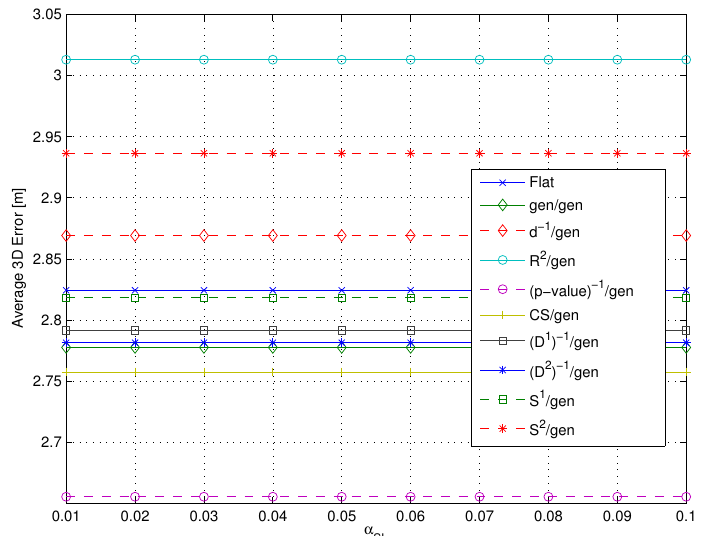
Figure 10. Impact of the m m /gen/ ( p -value ) − 1 1